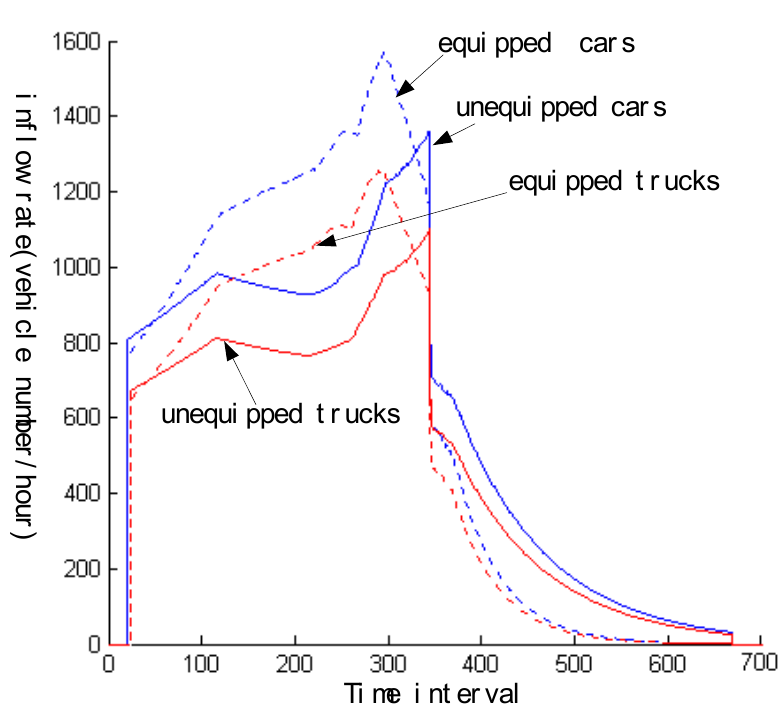
Figure 8. Link 4’s inflow rate of truck and car